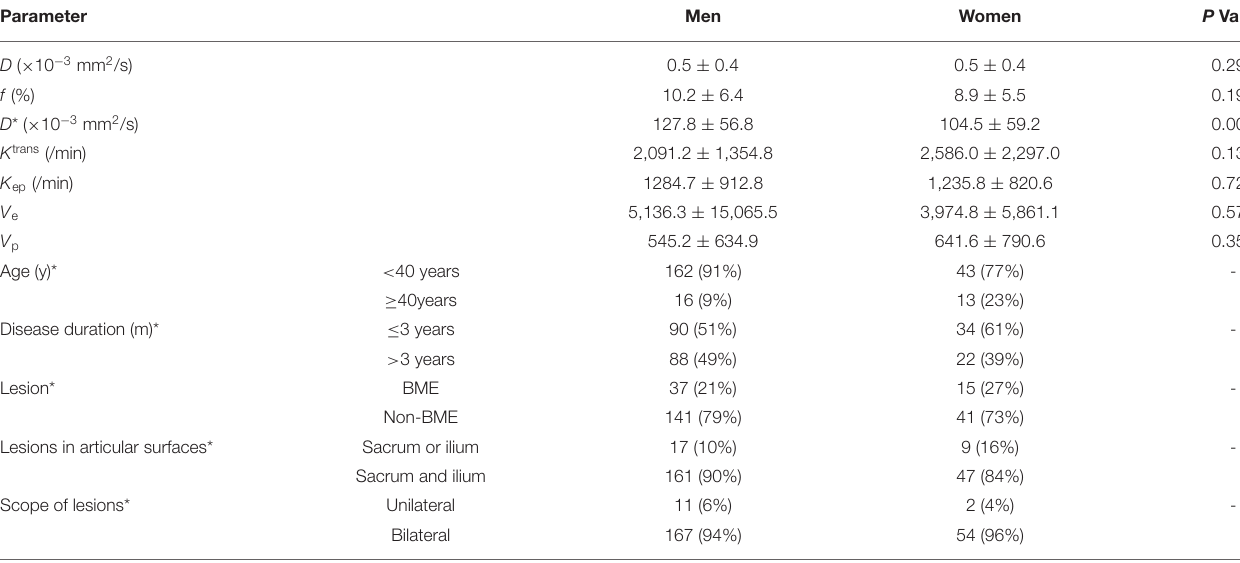
TABLE 2 | Intravoxel incoherent motion (IVIM)-derived parameters according to clinical-pathologic features of 234 spondyloarthritis (SpA). Parameter